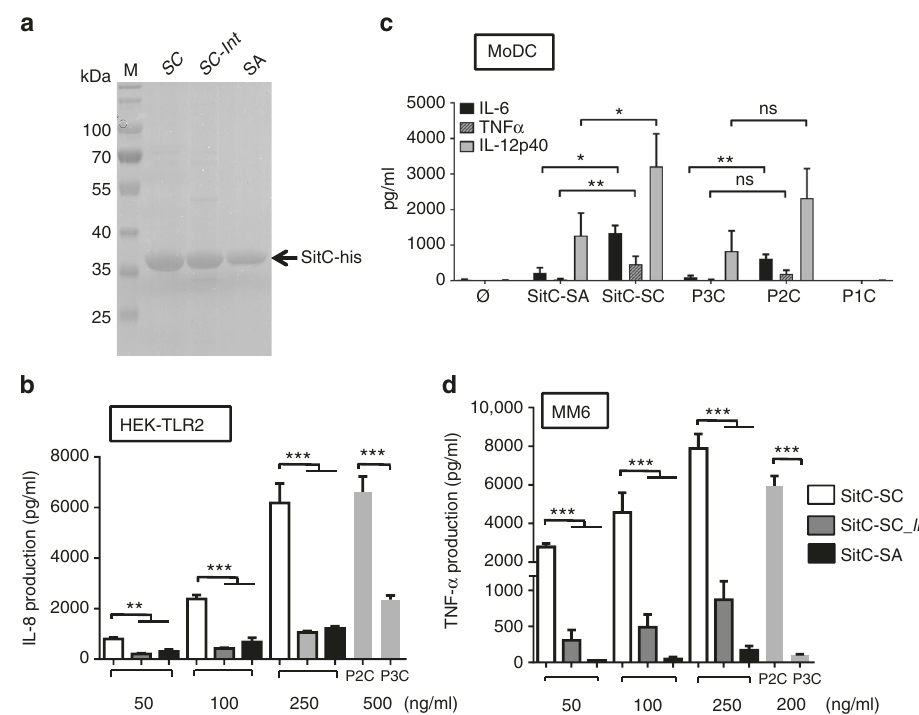
Fig. 2 Puri fi ed SitC-SC induced ten times higher TLR2 signaling than SitC-SA. ( a ) The Coomassie blue-stained SDS page of puri fi ed SitC from S. carnosus (SitC-SC) , S. carnosus pCX -lnt (SitC-SC lnt ), and S. aureus SA113 (SitC-SA); M, size standard. ( b ) IL-8 production (pg/ml) after 18-h stimulation of permanent TLR2-transfected HEK cells with puri fi ed SitC from S. carnosus (SitC-SC), S. carnosus pCX -lnt (SitC-SC lnt ), and S. aureus SA113 (SitC-SA) with different concentrations (50, 100, and 250 ng/ml). For positive controls, synthetic Lpp Pam 2 CSK 4 (P2C) and Pam 3 CSK 4 (P3C) were applied in the same concentration (500 ng/ml). The experiments in triplicate were conducted at least three times. Error bars indicate standard error. Statistical signi fi cances were calculated by using Student ’ s t tests or analysis of variance (ANOVA): not signi fi cant P > 0.05, * P < 0.05, ** P < 0.01, *** P < 0.001. ( c )